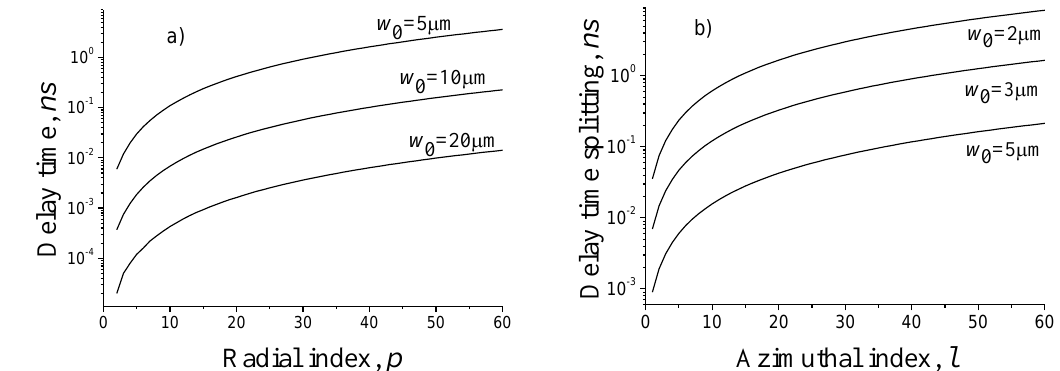
Figure 9. Dependence of the delay time ( a ) and group delay splitting ( b ) on the radial and azimuthal indices, accordingly, 1.5 n = z = 1 km, 0